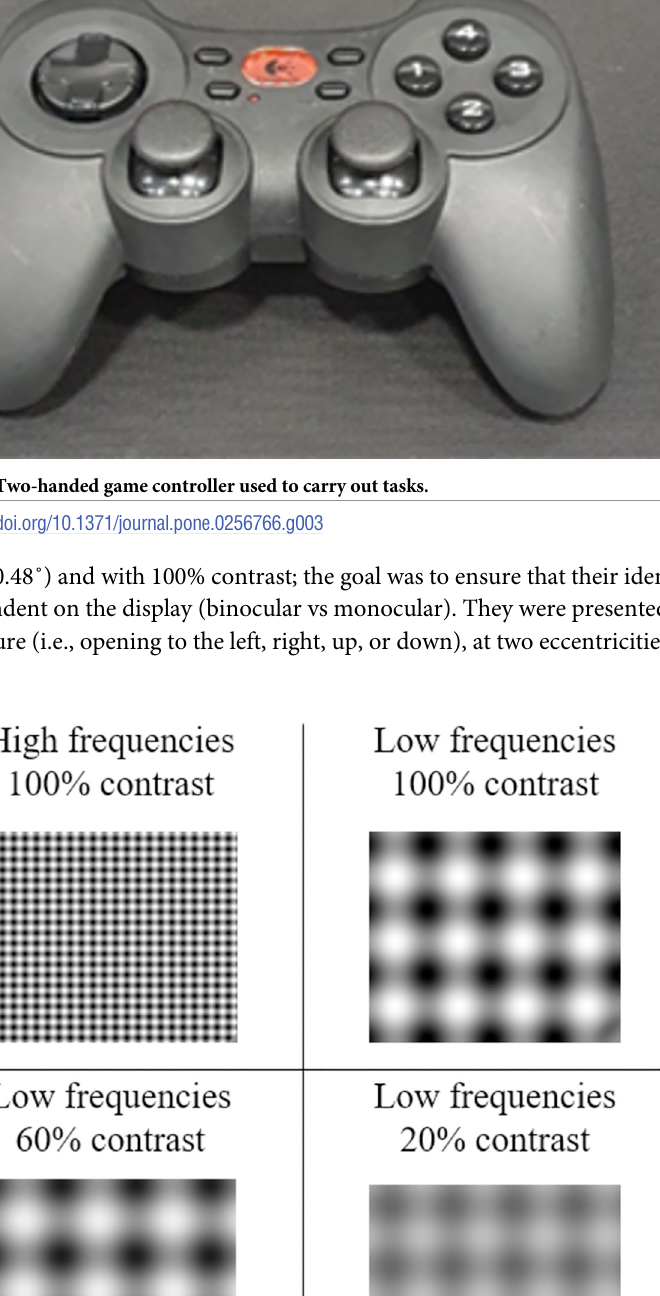
Fig 4. Binocular background according to the four display conditions: HSF-100%, LSF-100%, LSF-60% and LSF- 20%.